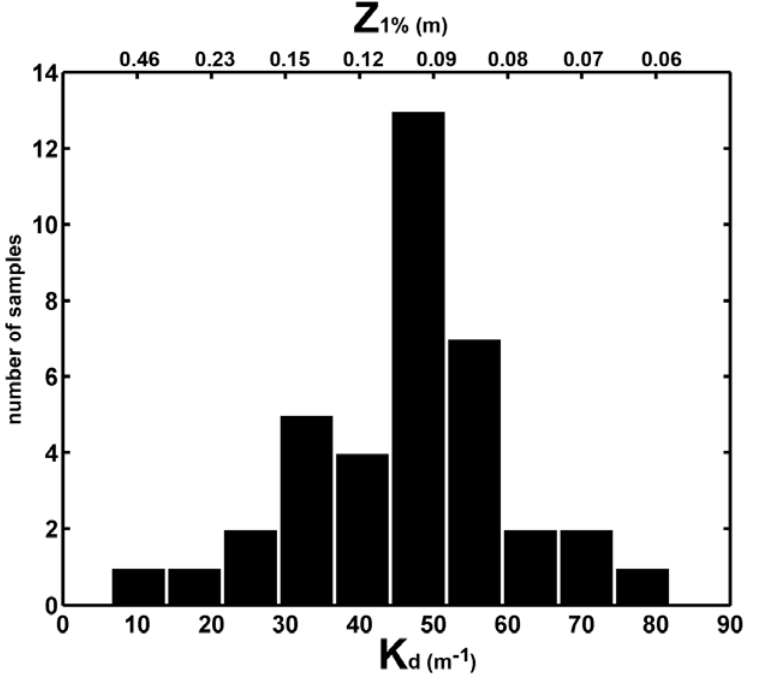
and photic depth (Z d